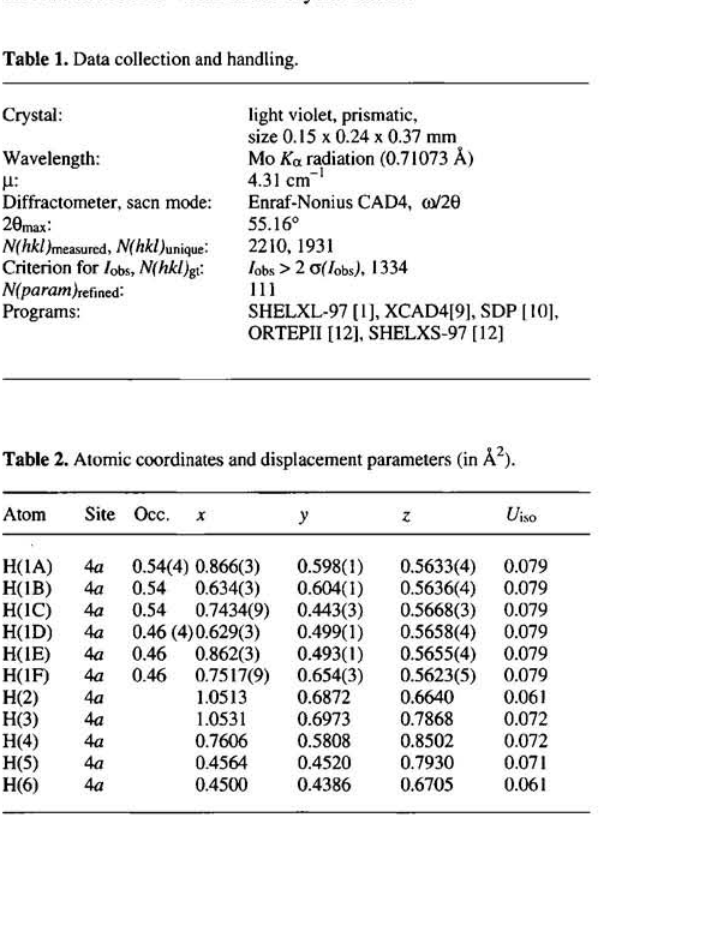
Table 1. Data collection and handling.